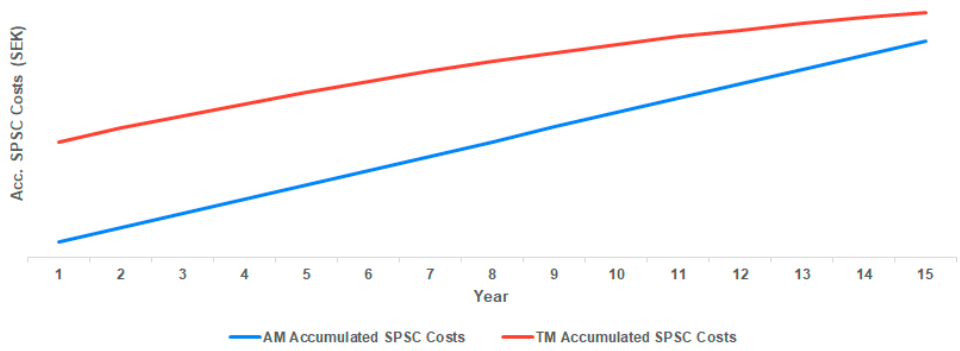
Figure 8. AM and TM accumulated SPSC costs for part P1 over the seven-year planning horizon.